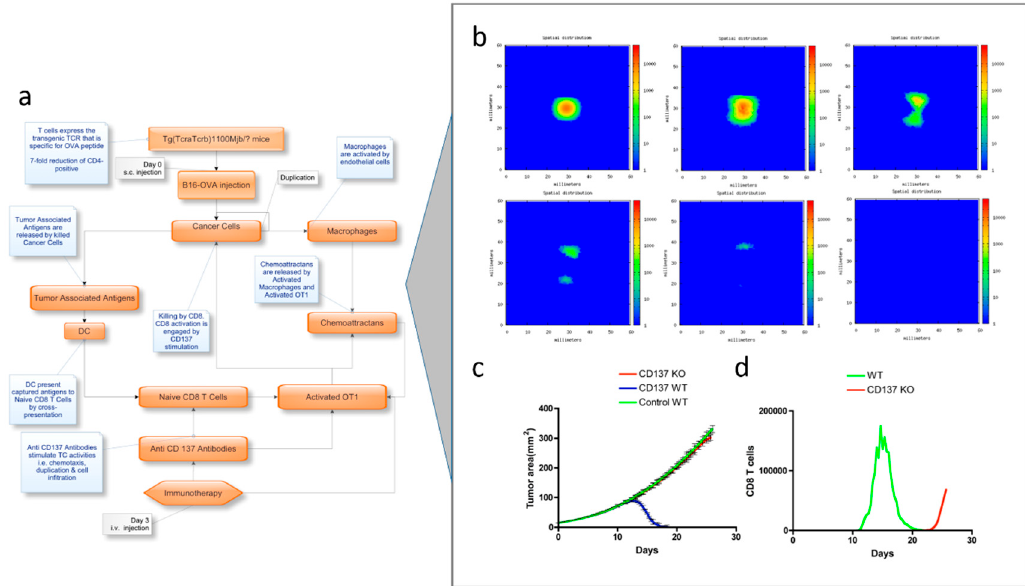
Figure 5. ( a ) Scheme of the modelling workflow, ( b ) Simulation dynamics results of the tumor growth in a virtual mouse after treatment with OT-1 T-cells and anti-CD137 monoclonal antibody, obtained at days 7, 41, 16, 20, 24, and 28 (from upper-left to lower-right). The effect of anti-CD137 in tumor infiltration is confirmed by the increased TC cell cytotoxicity and by the chemotaxis gradients. ( c , d ) Model prediction results obtained from the in silico study suggesting that the combined therapy with OT-1 T-cells and anti-CD137 monoclonal antibody) was not efficient in eliminating murine B16OVA melanoma with no expression of CD137 on endothelium ( c ). When comparing with wild-type in silico mice, the CD8 T cell infiltration was drastically reduced and delayed in time ( d ). Adapted from [116] under a CC BY 4.0 License. Copyright Pappalardo, F., Forero, I.M., Pennisi, M., Palazon, A., Melero, I. and Motta S., 2011.